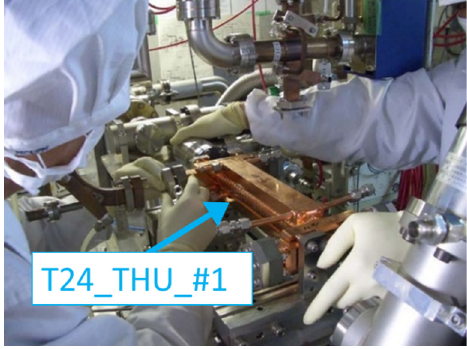
FIG. 3. Installation of the structure.